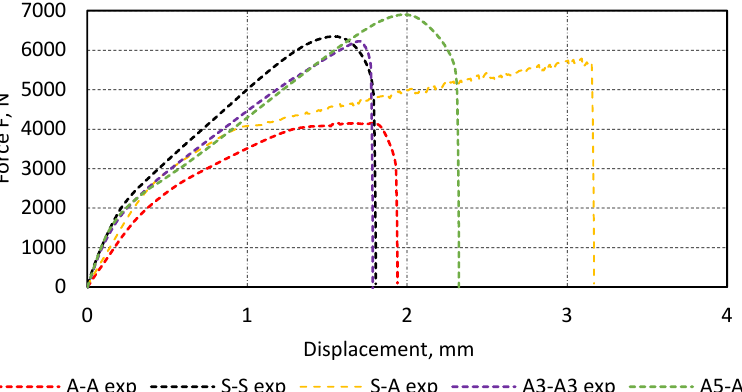
Table 4. Mechanical properties of adherend materials.